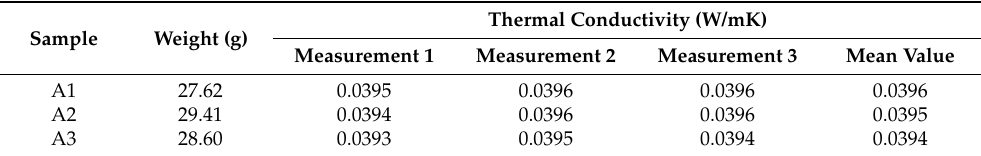
Table 1. Initial measurement values.